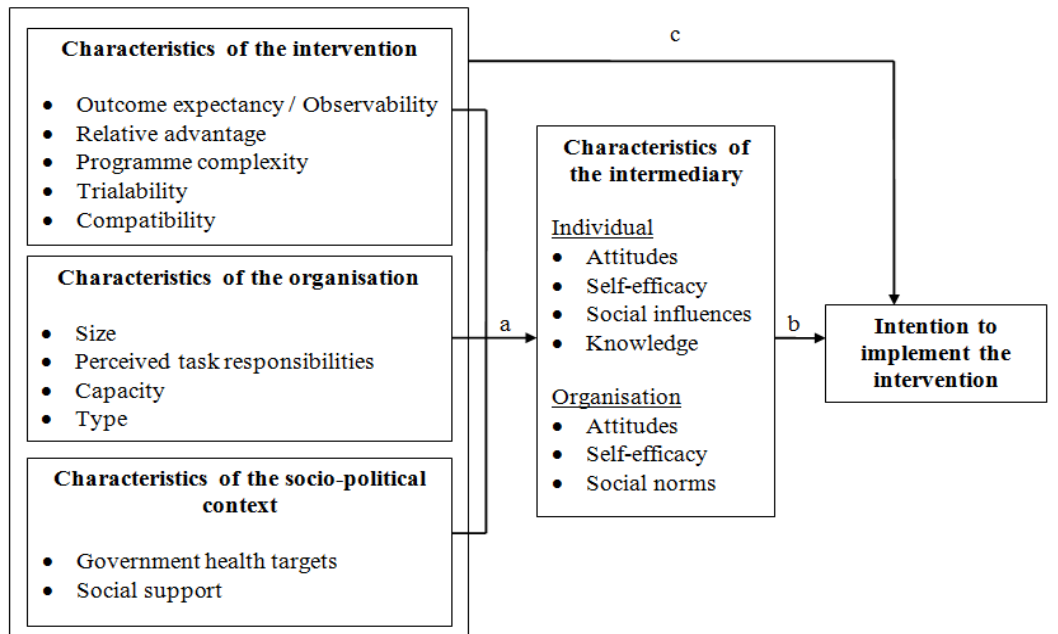
Figure 1. The theoretical